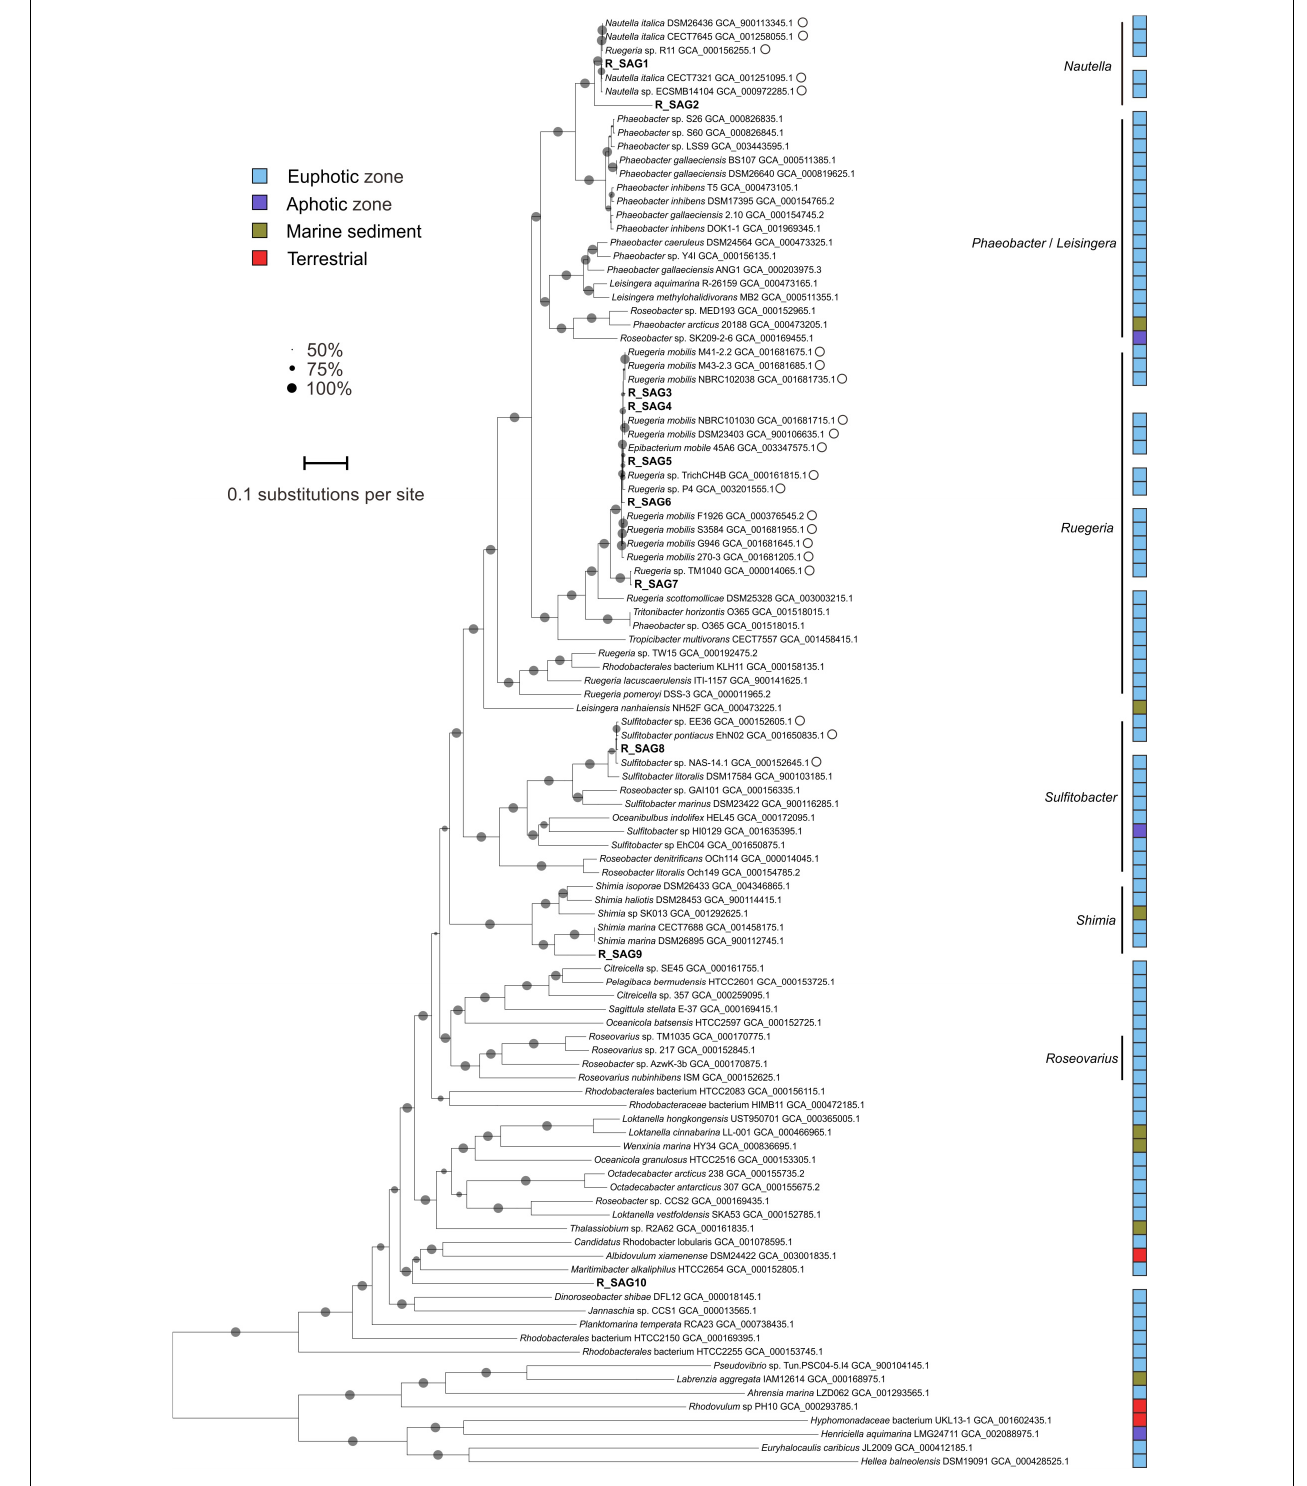
FIGURE 1 | Maximum-likelihood phylogenetic tree of Roseobacter genomes based on the amino acid sequences of 120 bacterial orthologs. The ten SAGs from this study are shown in bold. GenBank accession numbers are shown for the reference genomes. Closely related genomes with an average nucleotide identity > 95% to at least one hadal SAG from the Mariana Trench are marked with open circles. Reference genomes from different niches are marked with colored squares, as identified in the legend inset. Bootstrap values > 50% are represented in the tree by gray circles; the size of the circle is proportional to the bootstrap value. The scale bar represents the number of amino acid substitutions per